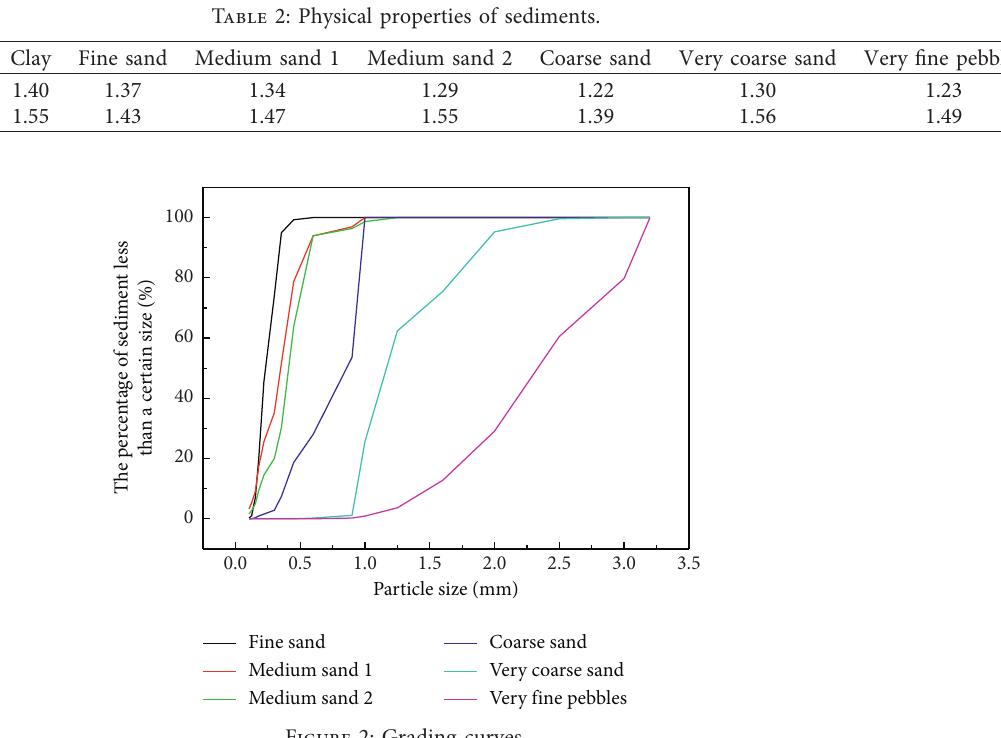
Figure 2: Grading curves.